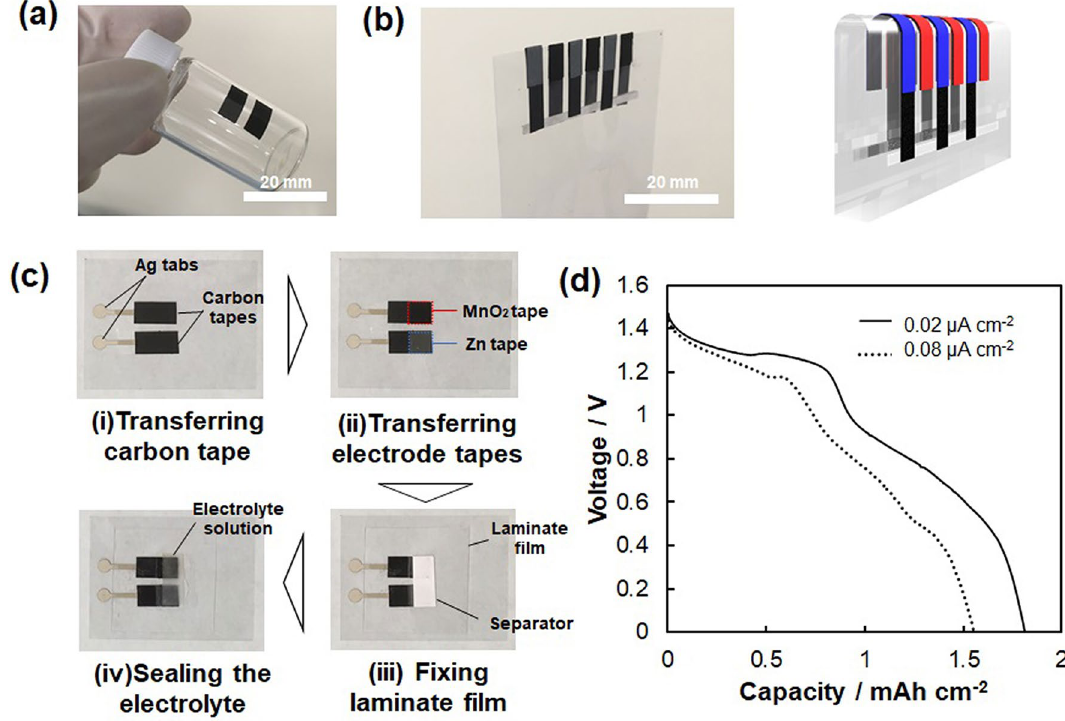
Figure 4. ( a , b ) Photograph of the transferred battery components onto the curved surface of a glass bottle ( a ) and the edge of PEN film ( b ). ( c ) The transfer-based fabrication process of the primary battery. ( d ) Discharging profile of the primary battery at different speeds of 0.02 and 0.08 µA cm −2 . The illustration in ( b ) was designed with the free software POV-Ray for windows—version